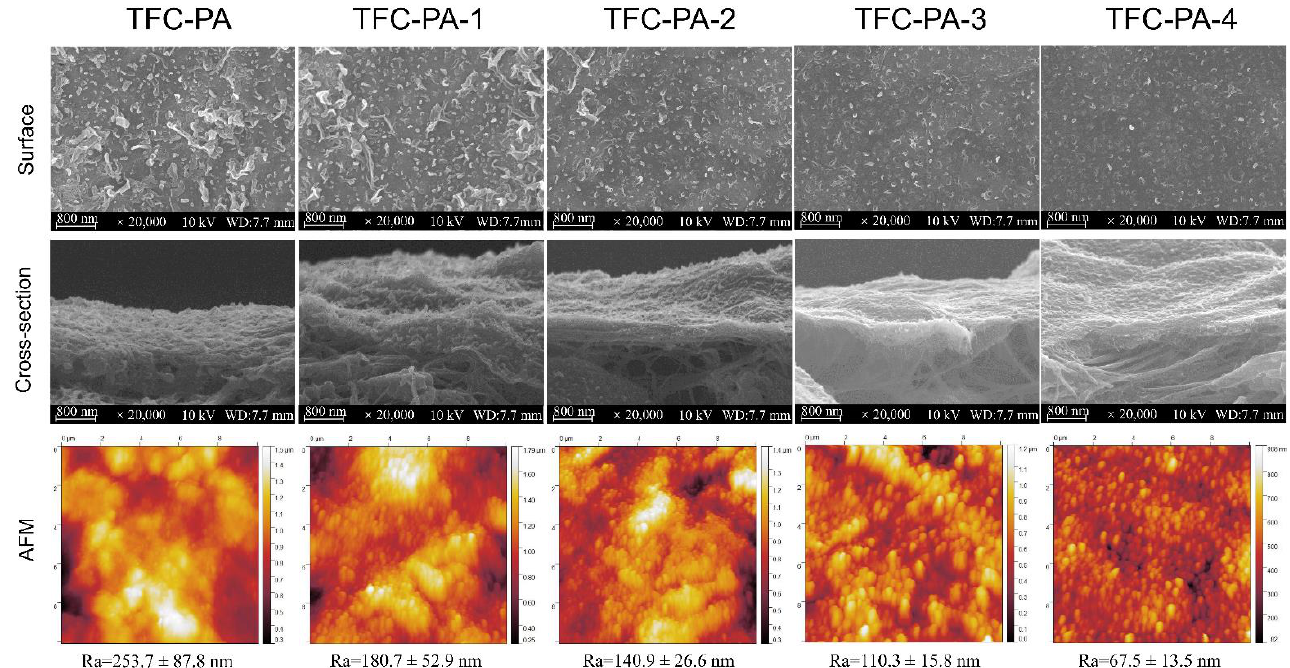
Figure 4. Surface and cross-sectional SEM images of the TFC-PA membranes with different CNT amounts, as well as their corresponding surface AFM images (TFC-PA-1~4 refer to the filtrated volume of CNT dispersion from 1 to 2, 3 and 4 mL).